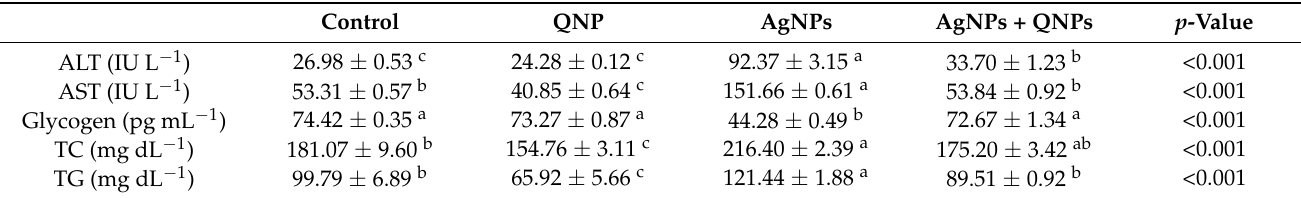
Table 3. Effect of QNPs on blood parameters in AgNPs-induced toxicity in Nile tilapia.